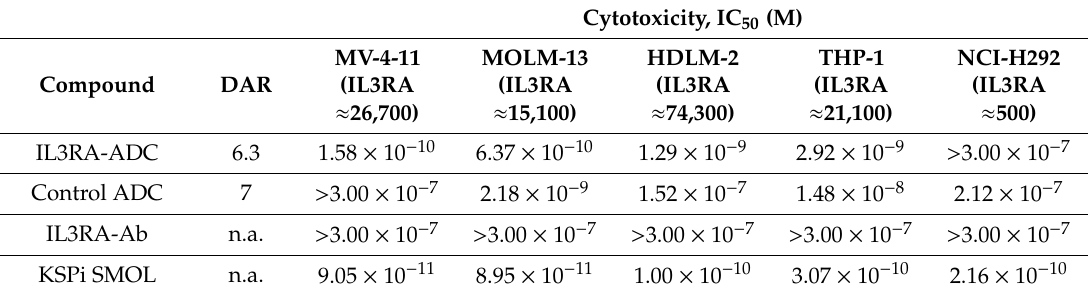
Table 2. The selectivity of IL3RA-ADC compared to the isotype control